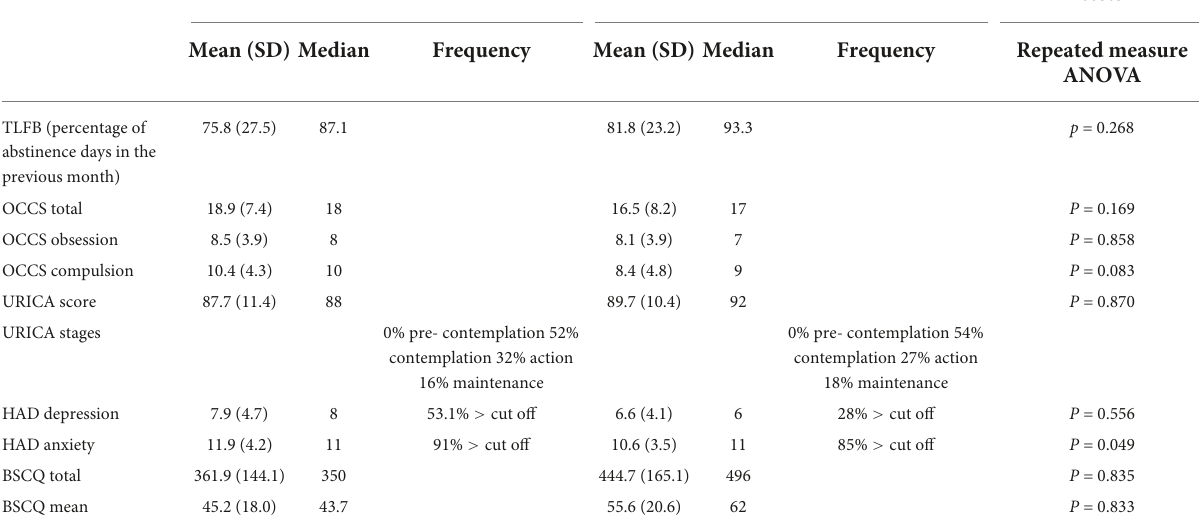
TABLE 2 Main assessment tools